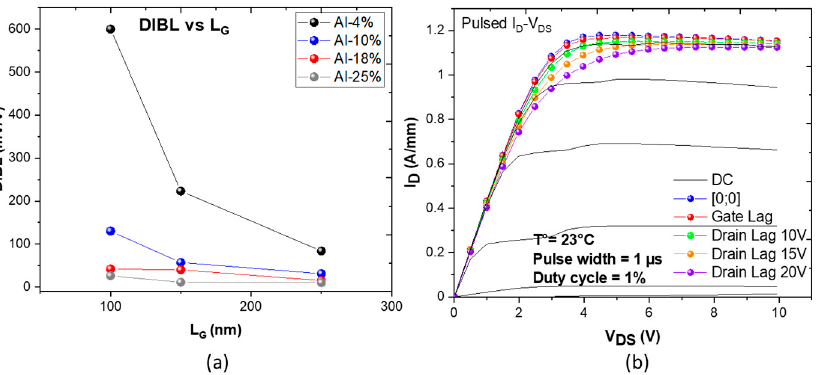
Figure 3. DIBL as a function of the gate length for AlN/GaN HEMTs with various Al-content in the AlGaN back barrier ( a ) and open channel pulsed I D –V DS output characteristics of 2 × 50 µm AlN/GaN HEMT (Al-25%) with L G = 100 nm and L GD = 0.5 µm ( b ).